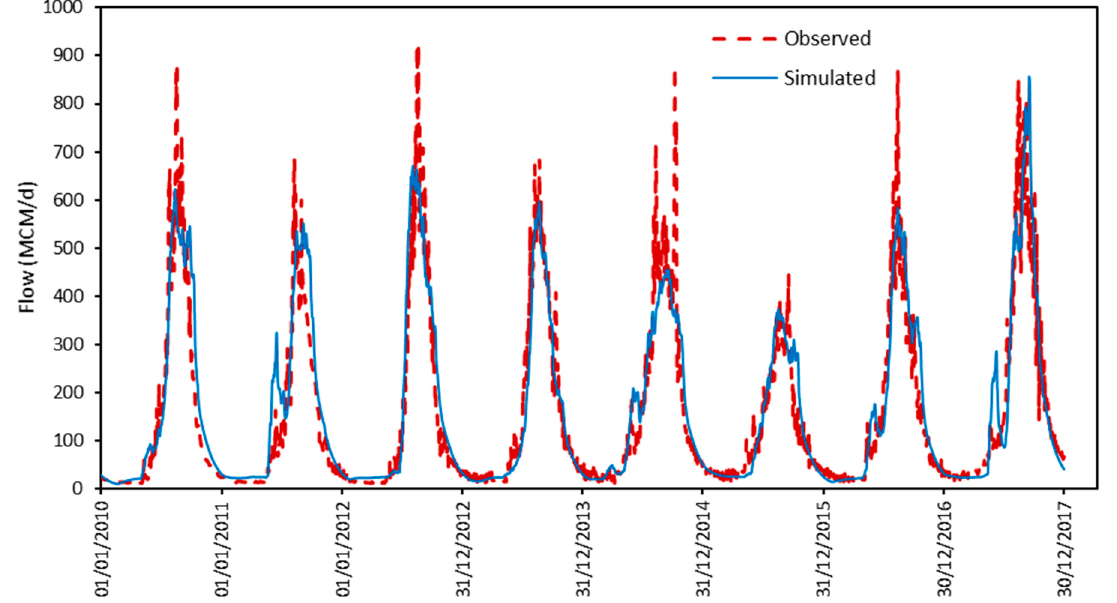
Figure 9. The comparison of observed and simulated flow at Diem station for the validated period.